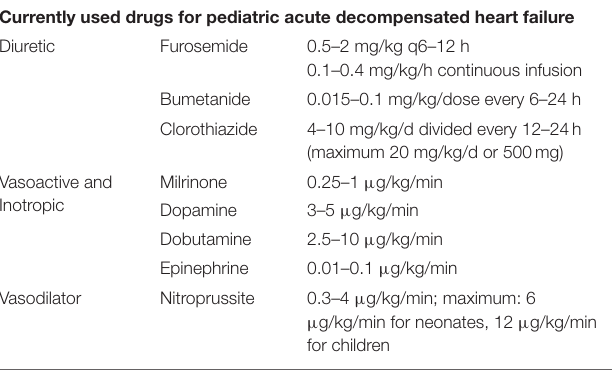
TABLE 1 | Medical therapies commonly required in the treatment of ADHF